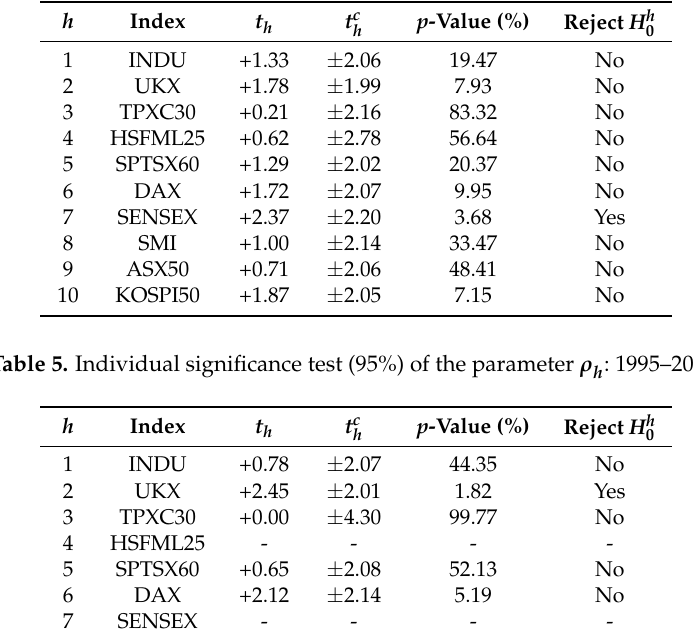
Table 4. Individual significance test (95%) of the parameter ρ